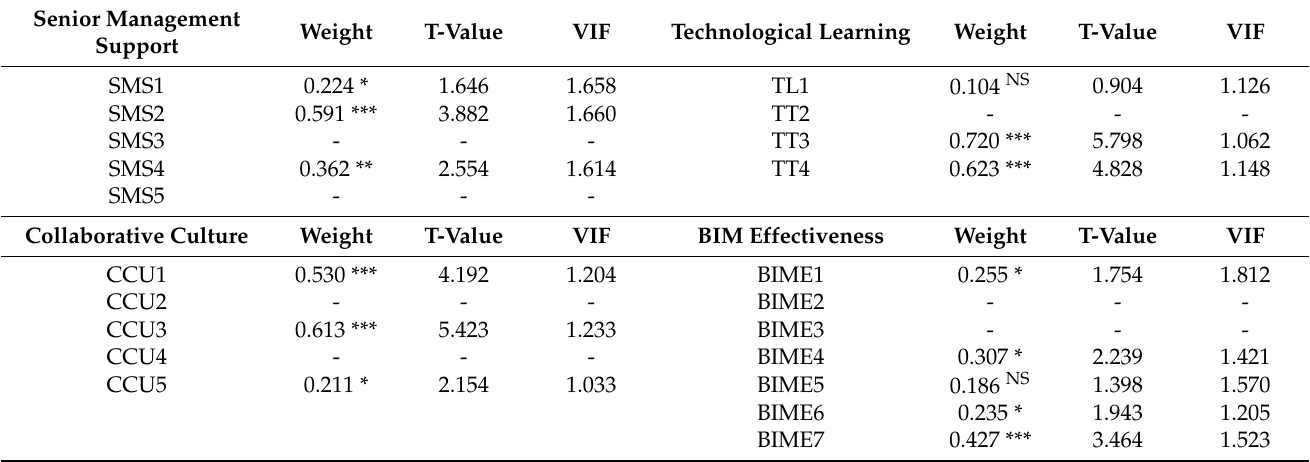
Table 3. Measurement model